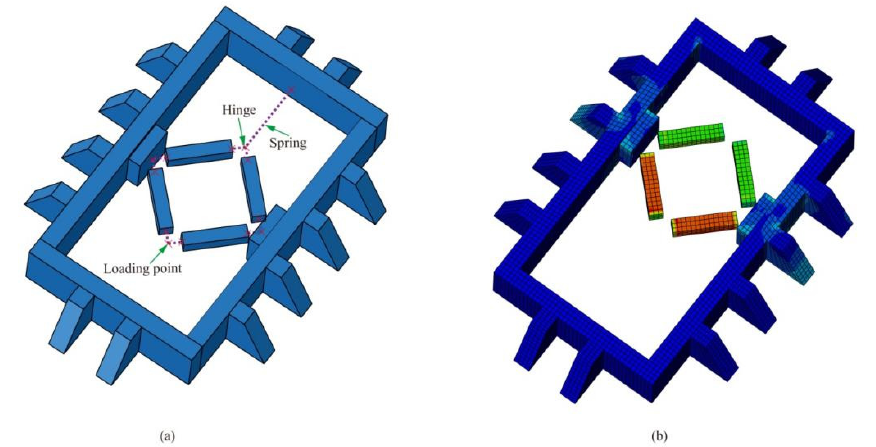
Figure 3. The numerical experiment of LFD: ( a ) arrangement; ( b ) Mises stress in the loading process.